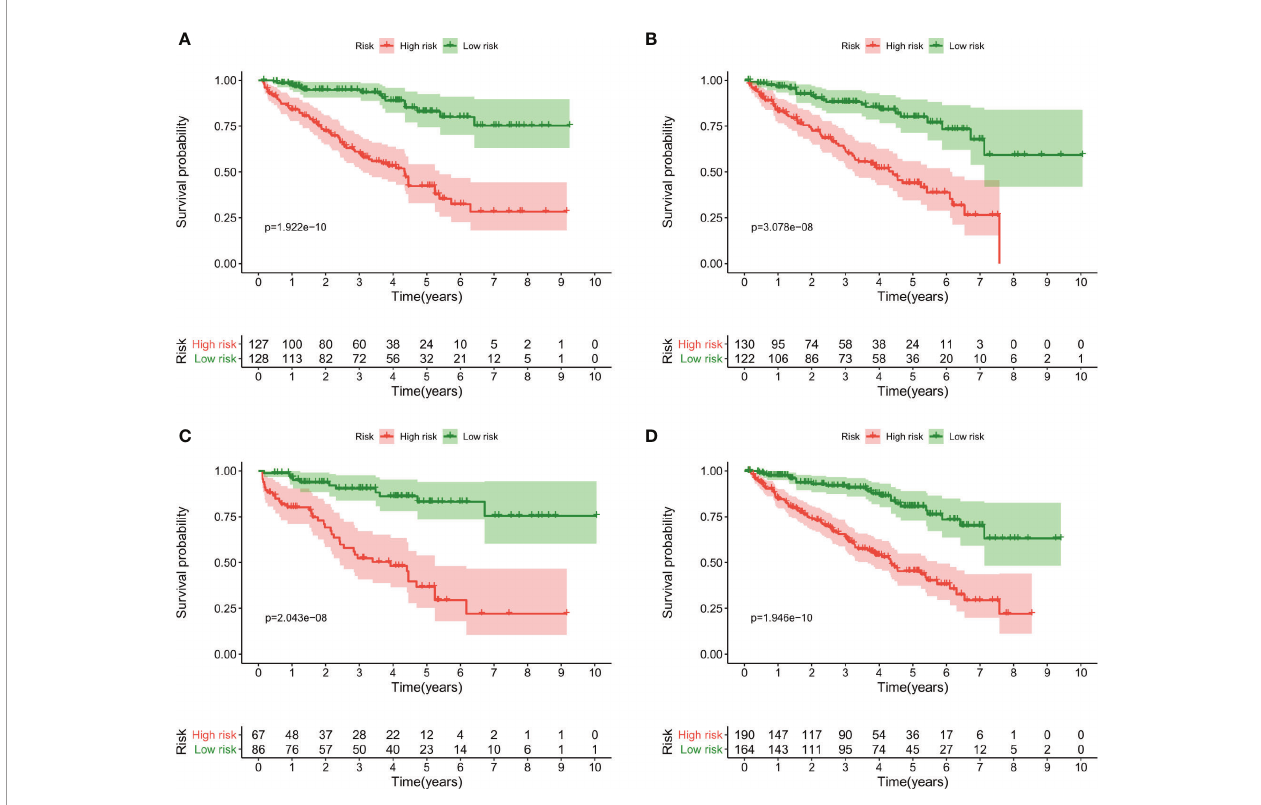
FIGURE 4 | Kaplan – Meier curves of overall survival for the high-risk and low-risk groups according to the median risk score. (A) The training dataset, (B) 1 st validation dataset, (C) 2 nd validation dataset and (D) 3 rd validation